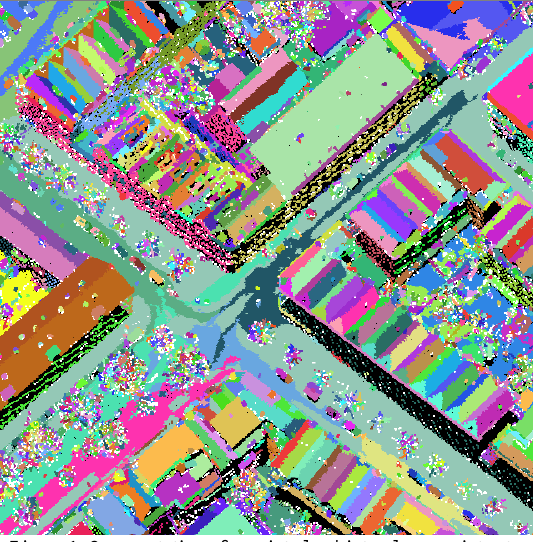
Figure 1. Segmentation of a point cloud into planar point